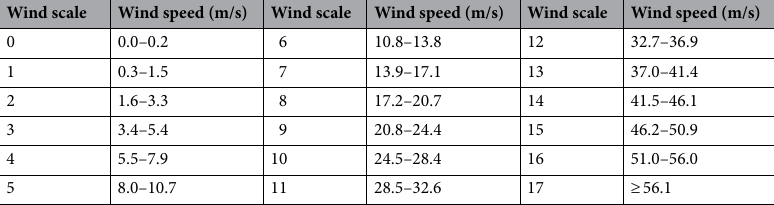
Table 1. Wind scale classification.